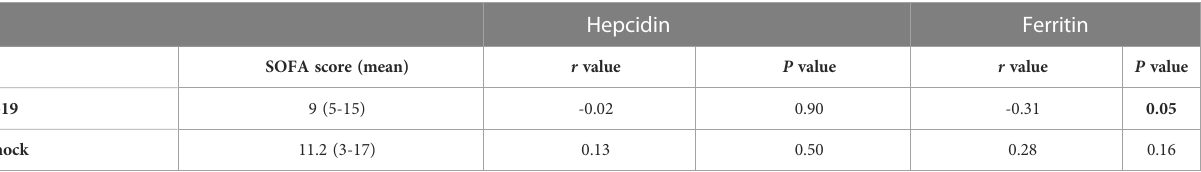
TABLE 4 Correlation between TP1 hepcidin or ferritin levels and SOFA scores of all enrolled patients.